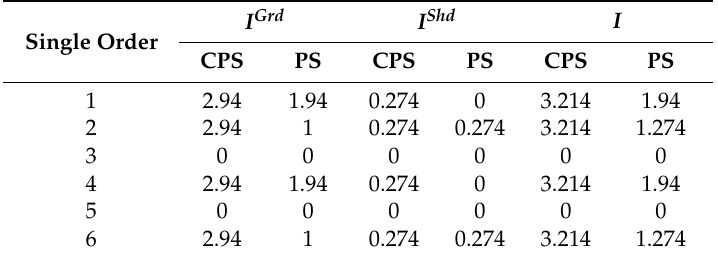
Table 5. Comparison of risk consequences in the operation of SCs in a CPS and a PS.